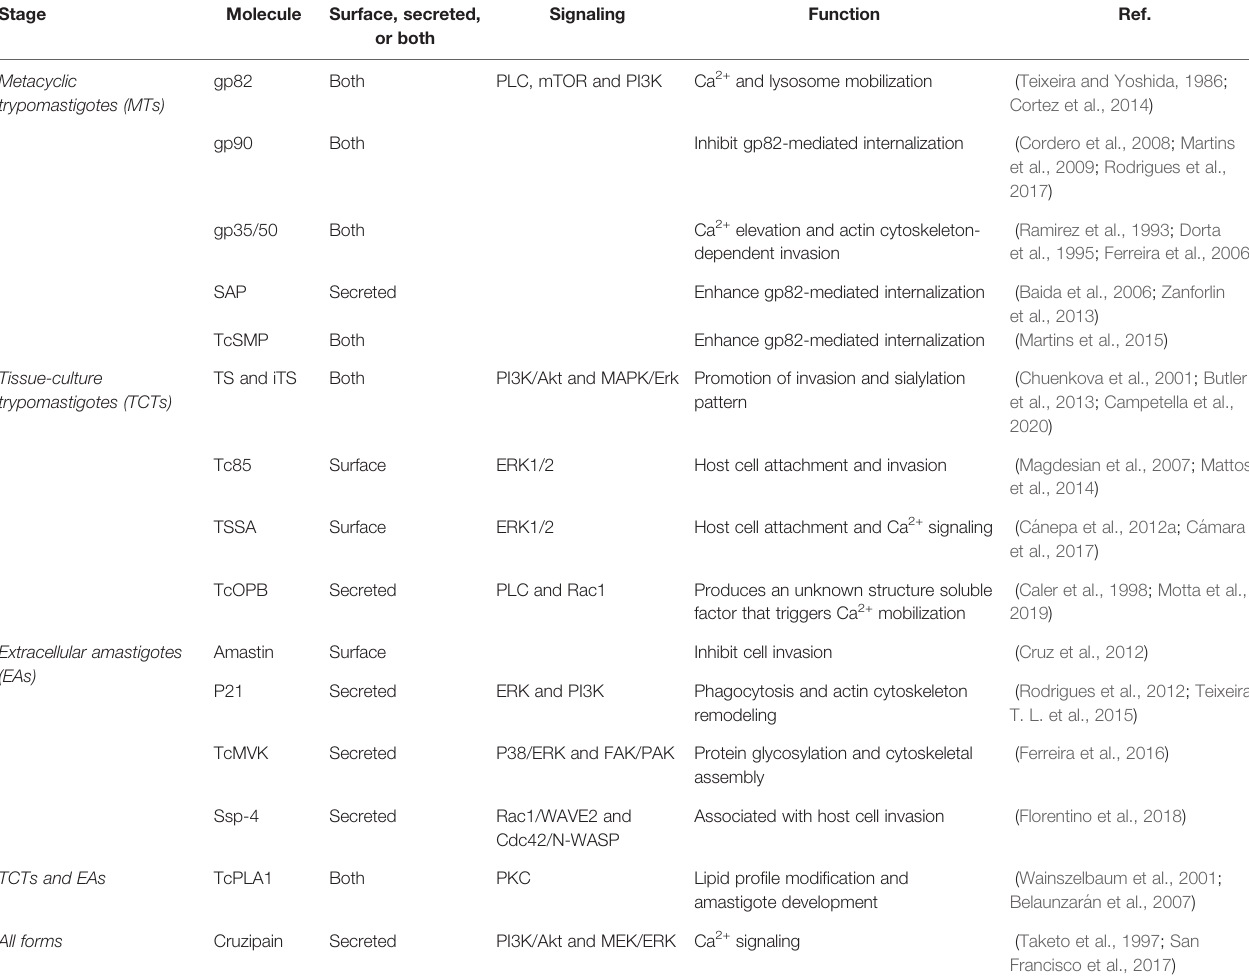
TABLE 1 | Stage-speci fi c proteins involved during invasion by T. cruzi